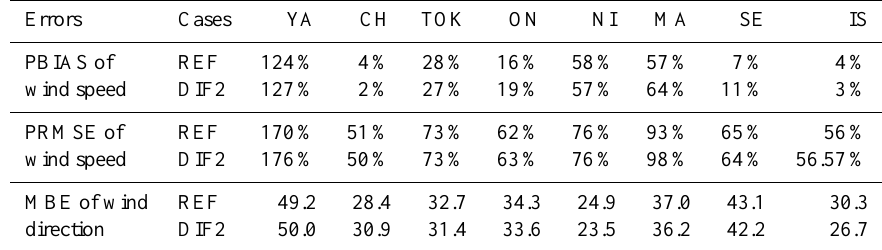
the south of FDNPP). The results of both 131 I and 137 Cs in- dicate that the difference between REF and DIF2 is small at CHIBA but large at YAMAGATA. At YAMAGATA, the total half of that in DIF2 on 20 March, while it is slightly